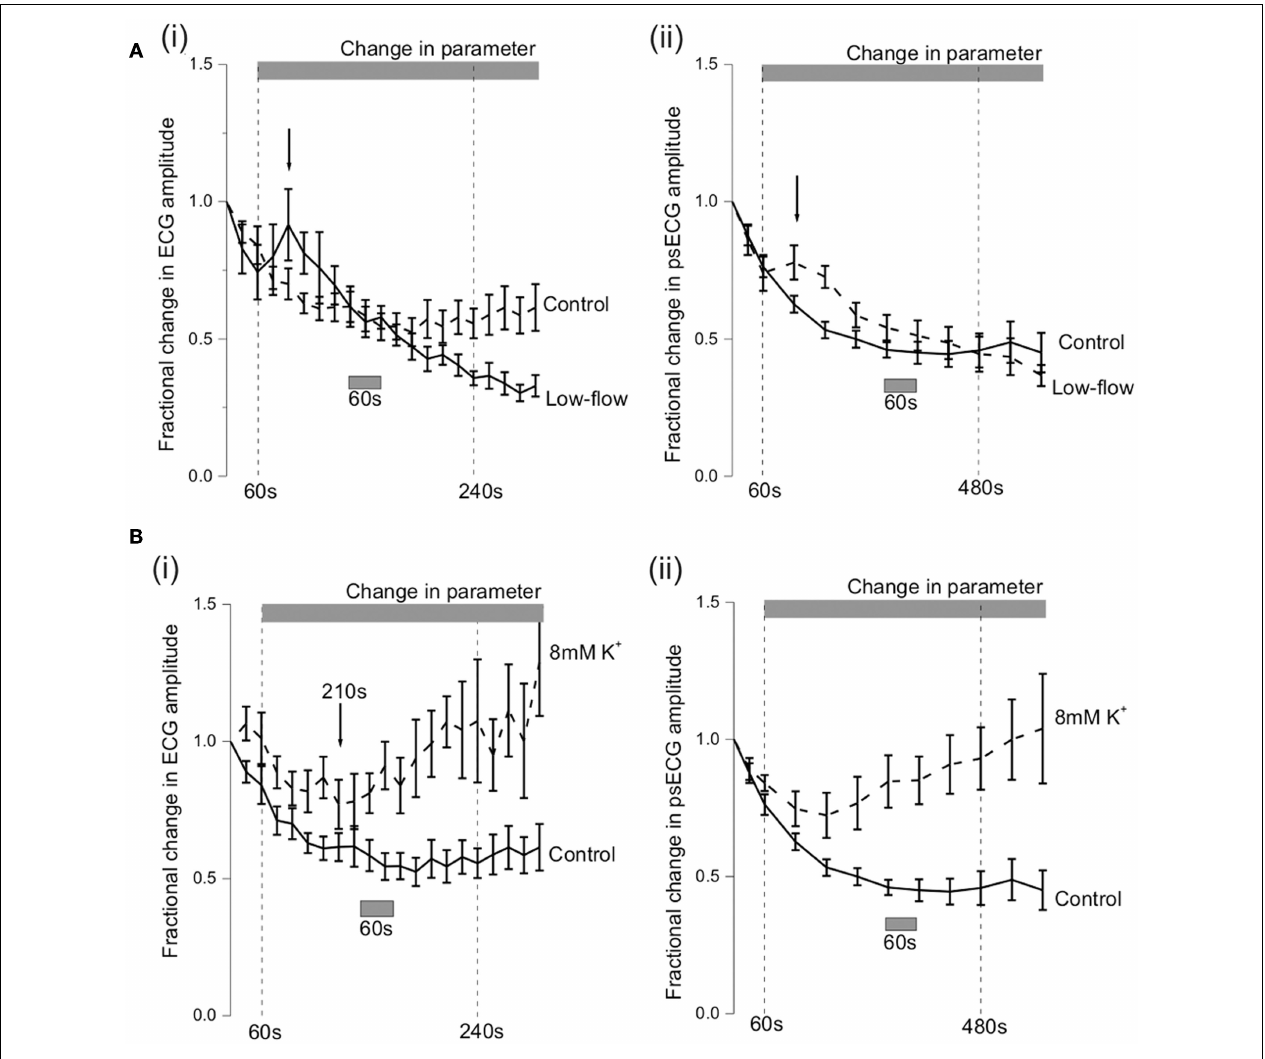
Shows the ECG and optical signal amplitude duringVF in 8mM ( n = 6) and 10mM ( n = 5) [K + ] solutions. (B) (i) Changes in ECG amplitude with time (** p < 0.01). (B) (ii) Changes in optical signal amplitude with time (*** p < 0.001). (All optical data corrected for signal